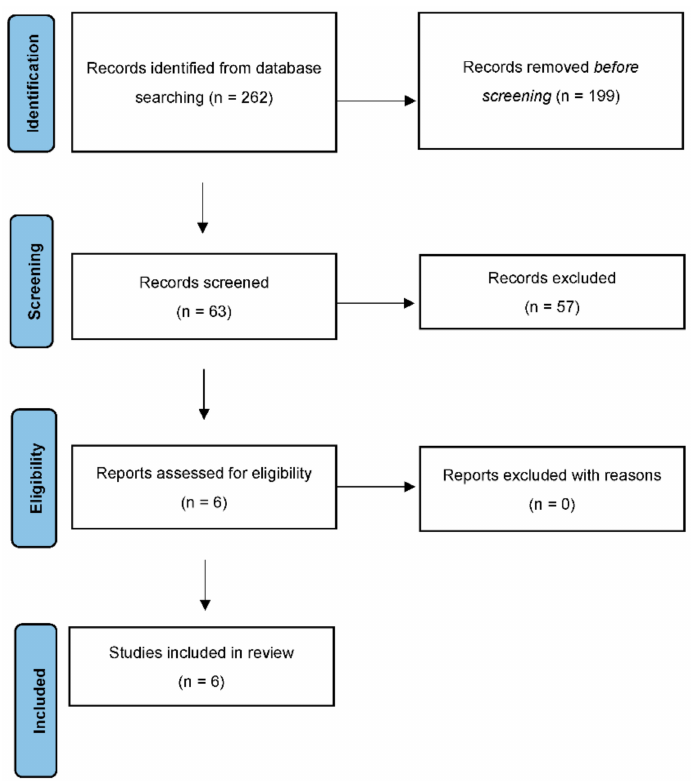
Figure 1. PRISMA 2009 Flow